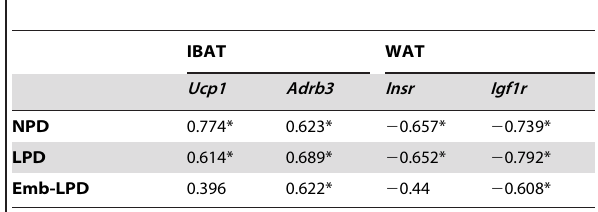
Table 10. Correlations (r values) of serum insulin levels with relative real-time RT-PCR expression values from interscapular brown adipose tissue (IBAT) and retroperitoneal white adipose tissue (WAT).